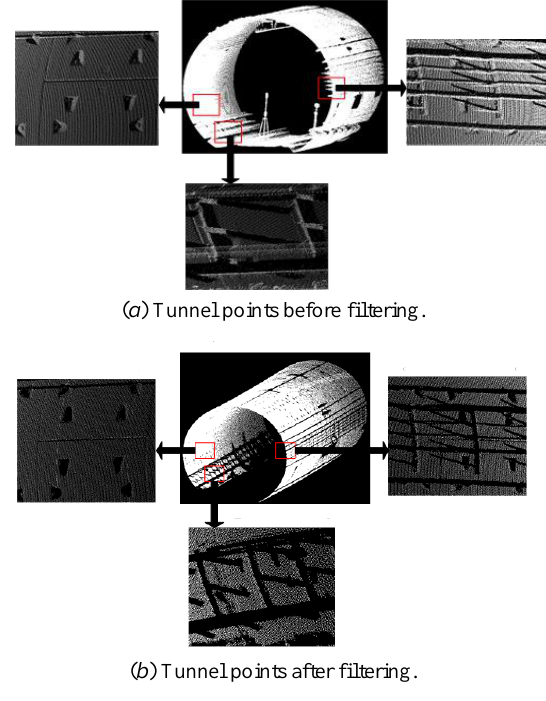
Fig.8 Tunnel filtering and localize amplification